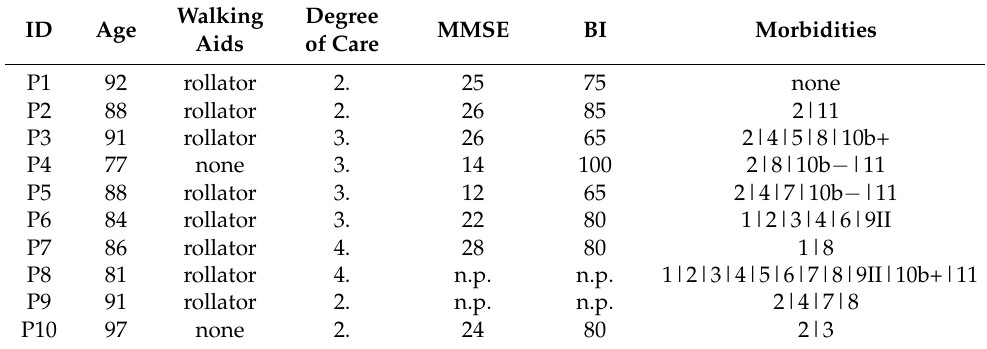
Table 3. Demographic, physical, cognitive and clinical data of nursing home